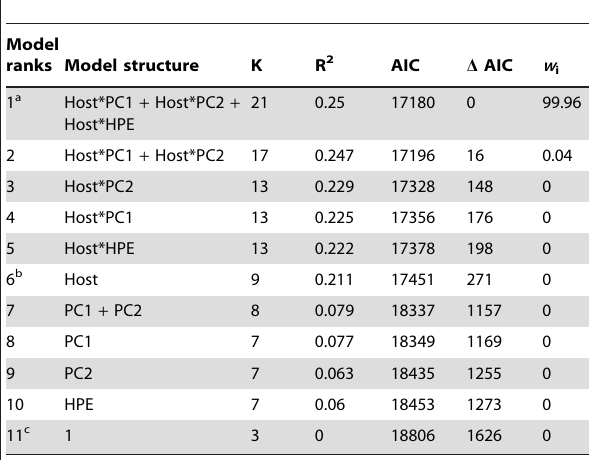
Models are ranked from the most supported (best model) to the least supported according to Akaike information criteria (AIC). D AIC – difference in AIC between the current and best model; w i – model probabilities. K – number of parameters in the model. Note that the number of parameters includes k , which is the dispersion parameter of the negative binomial distribution (see Protocol S1 for details). Host – host species; PC1 and PC2 – principal components of the seven environmental variables; HPE – Human population density estimate (see Methods for details).